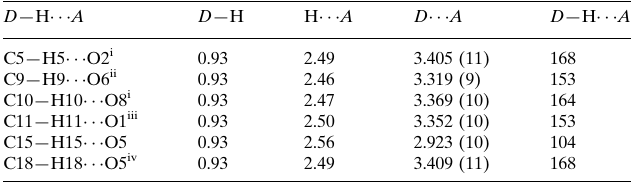
Hydrogen-bond geometry (A˚ , (cid:1)